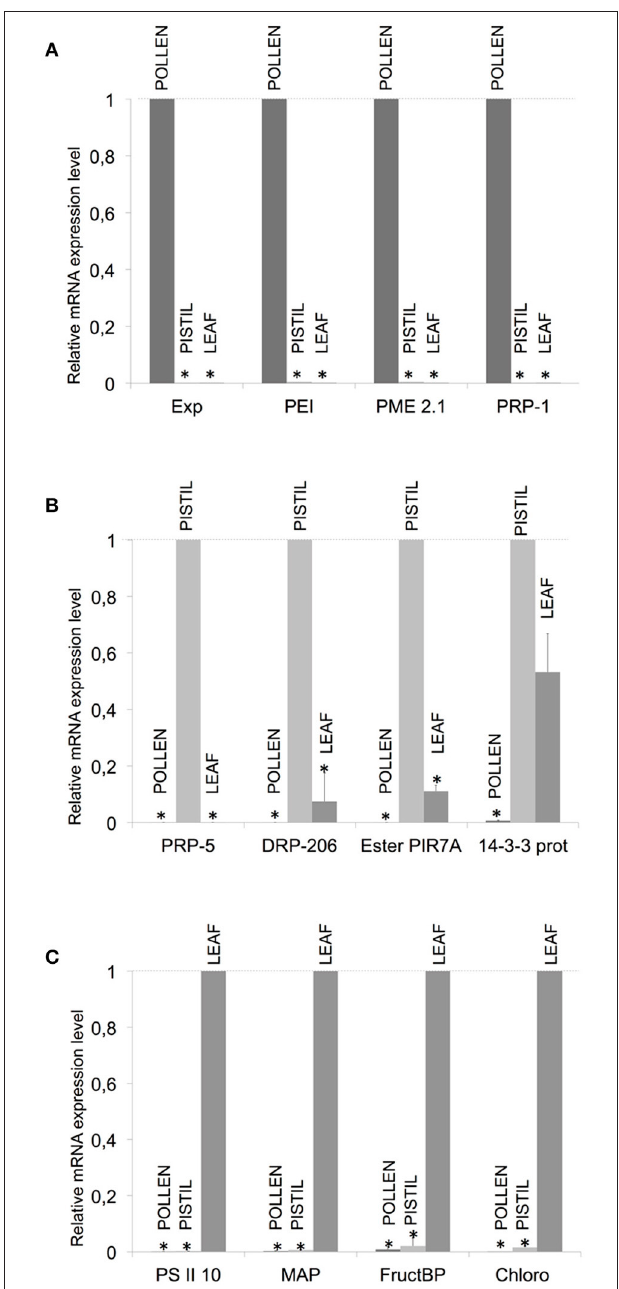
FIGURE 2 | Validation of the generation of SSH libraries by qPCR of selected transcripts. Several pairs of primers were designed for pollen- (PoP library), pistil- (PPo library) and leaf-preferentially expressed (LPo library) transcripts ( A–C , respectively). Exp, Expansin 11 precursor; PEI, Pectinesterase inhibitor 21;PME2.1,Pectinmetilesterase2.1;PRP-1,PathogenesisRelatedProtein-1; PRP-1, Pathogenesis Related Protein-5; DRP-206, Disease Resistance Response Prot-206; EsterPIR7A, Esterase PIR7A; 14-3-3 prot, 14-3-3 protein; PSII, Photosystem II 10 KDa polypeptide; MAP, Mitogen-activated protein kinase 3; FructBP, Fructose-bisphosphate aldolase; Chloro, Chlorophyll a-b binding protein. mRNA expression levels (average ± SD) of each transcript analyzed are shown in the three different tissues after normalization with the average expression of Katanin and Zinc-finger as housekeeping genes, made relative to the most expressed transcript ( y -value: